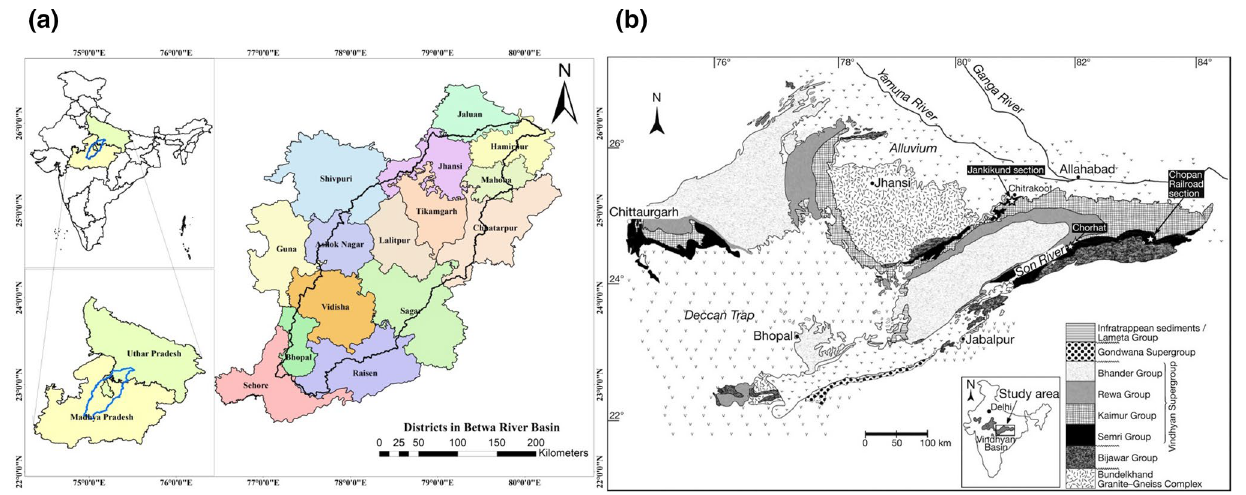
Fig. 1 Betwa River basin: a location map and b geology of the study